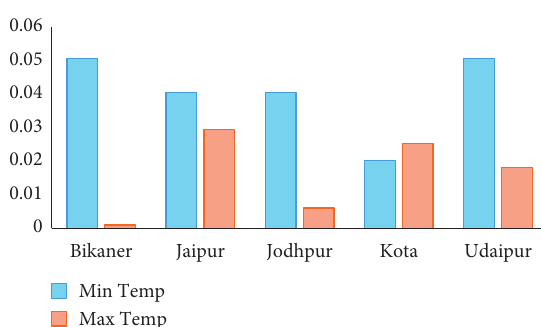
Figure 3: Sen’s slope for temperature at different stations.